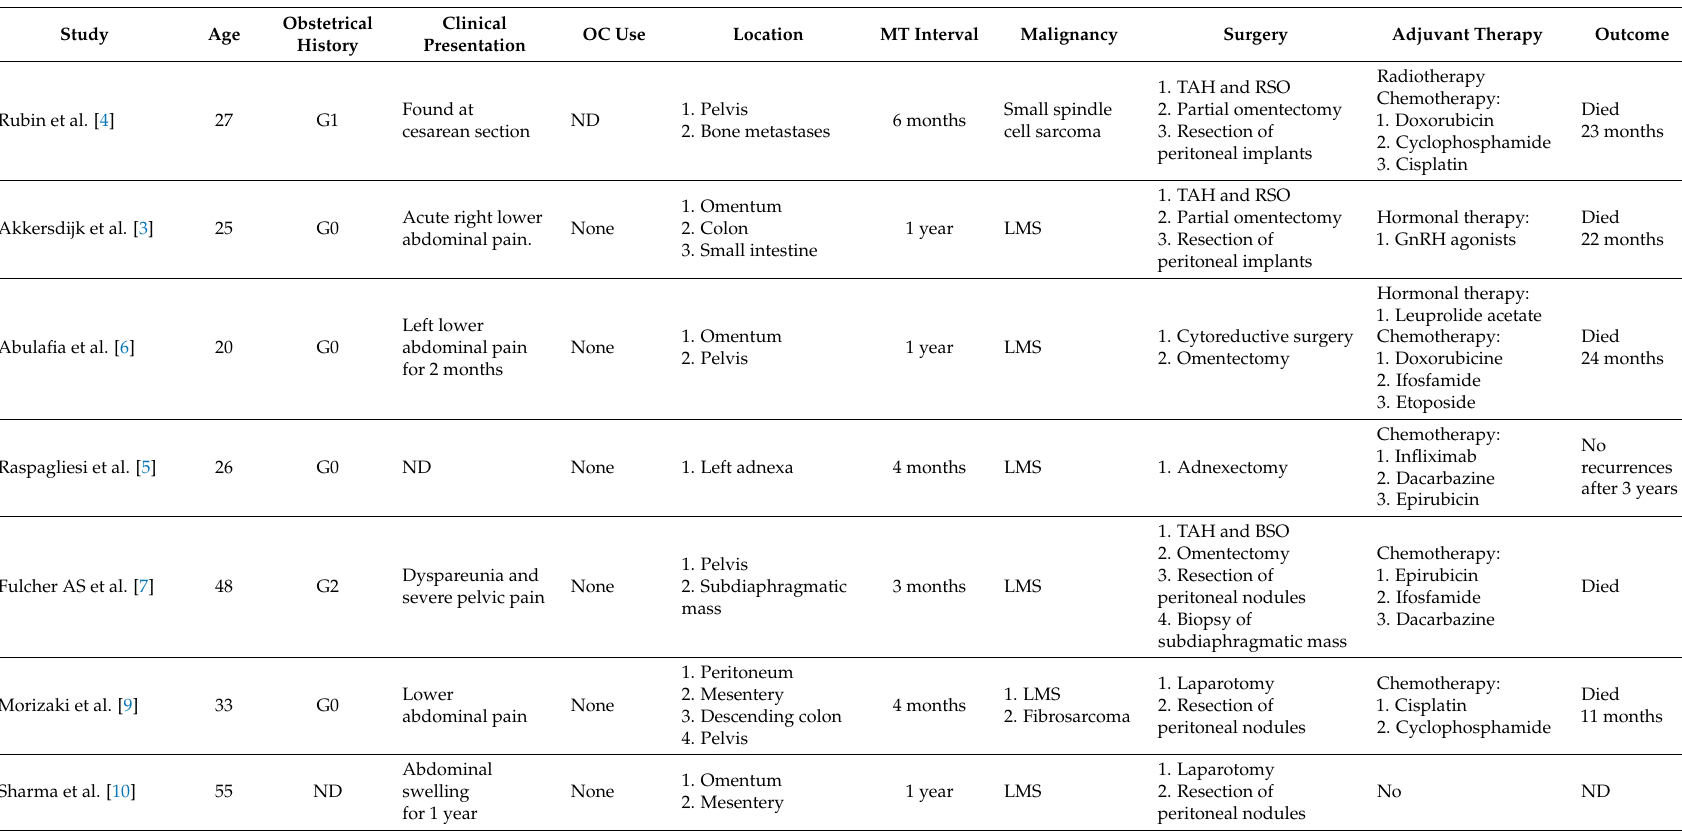
Table 1. A summary of previously reported cases of disseminated peritoneal leiomyomatosis with malignant transformation in